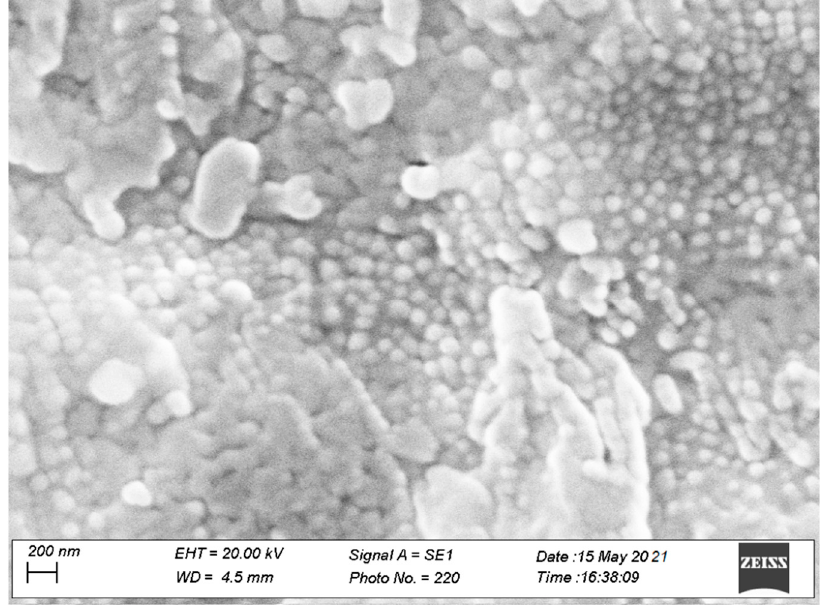
Figure 2. QRC-NLC-A surface morphology evaluated by SEM analysis; magnitude bar: 200 nm. Table 7. Particle size (nm), PDI, and Z-potential (mV) ± SE of QRC-NLC-CPX and NLC-CPX samples. Sample Particle Size